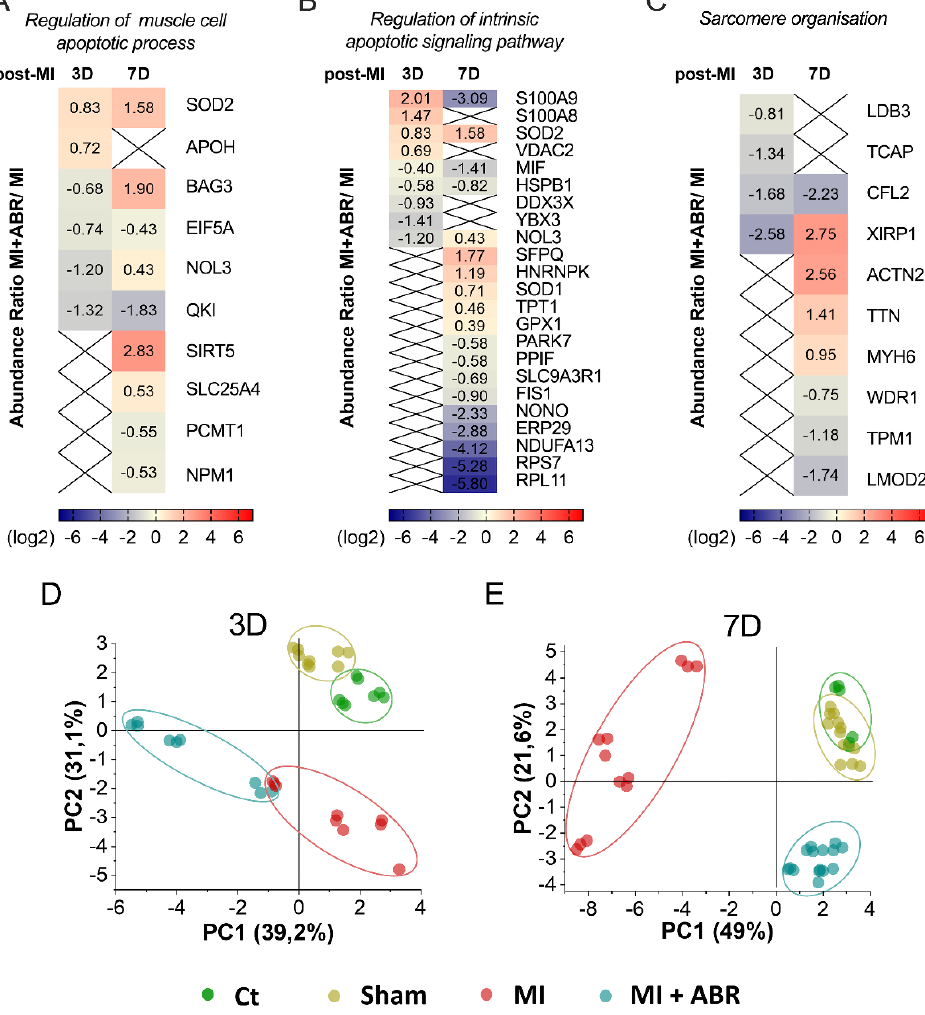
Figure 4. Heatmaps and principal component analysis (PCA) of the relative abundance of DEPs controlling biological processes involved in myocardial repair and remodeling. ( A ) DEPs involved in the regulation of the muscle cell apoptotic process, ( B ) regulation of the intrinsic apoptotic signaling pathway and ( C ) sarcomere organization. Red represents upregulated and blue represents downregulated proteins in the LV collected from the MI + ABR group compared to MI mice. DEPs were considered to be significant at an adjusted p value < 0.05. The calculated p value was obtained using ANOVA hypothesis test and adjusted using Benjamini-Hochberg correction for the false discovery rate (FDR). Colored bars indicate the expression levels. X-marking represents proteins that were not significantly different between the groups. PCA score plot based on the LC-MS/MS data of DEPs involved in the regulation of the muscle cell apoptotic process, regulation of the intrinsic apoptotic signaling pathway, and sarcomere organization GO BP for all experimental groups at 3 days ( D ) and 7 days ( E ) post-MI. An ellipse highlights the data points coming from one group samples, which were run in three technical replicates (dots) and are added for visual purposes only. The colors of dots are: green, control (Ct) unoperated mice; dark yellow, Sham operated mice; red, MI mice; blue, MI + ABR mice. All protein short names are mentioned by the gene nomenclature